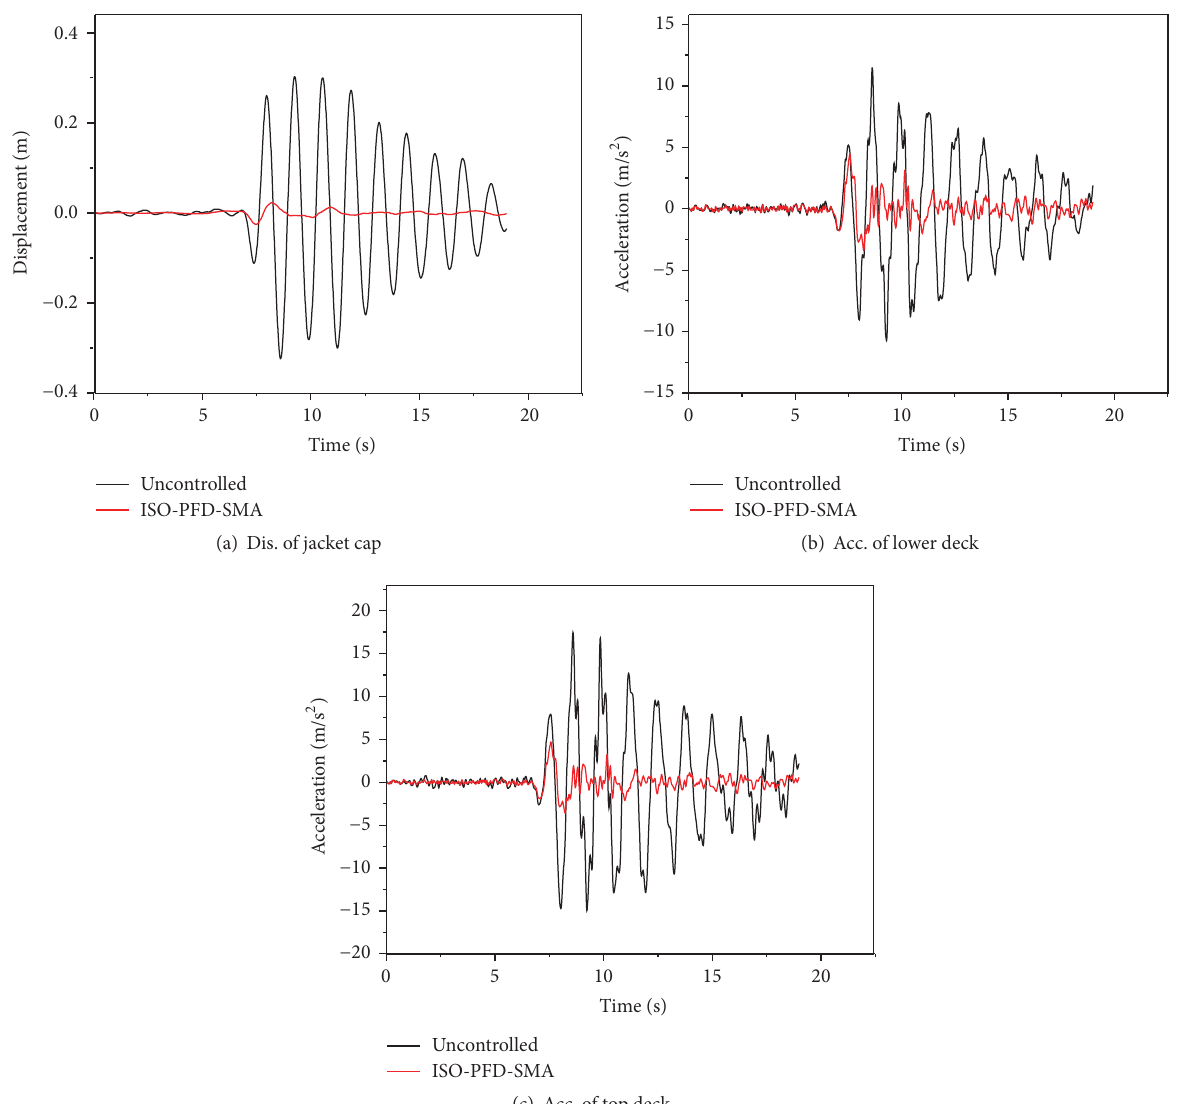
Figure 12: Computational response of JZ20-2MQU model under Tianjin earthquake excitation.